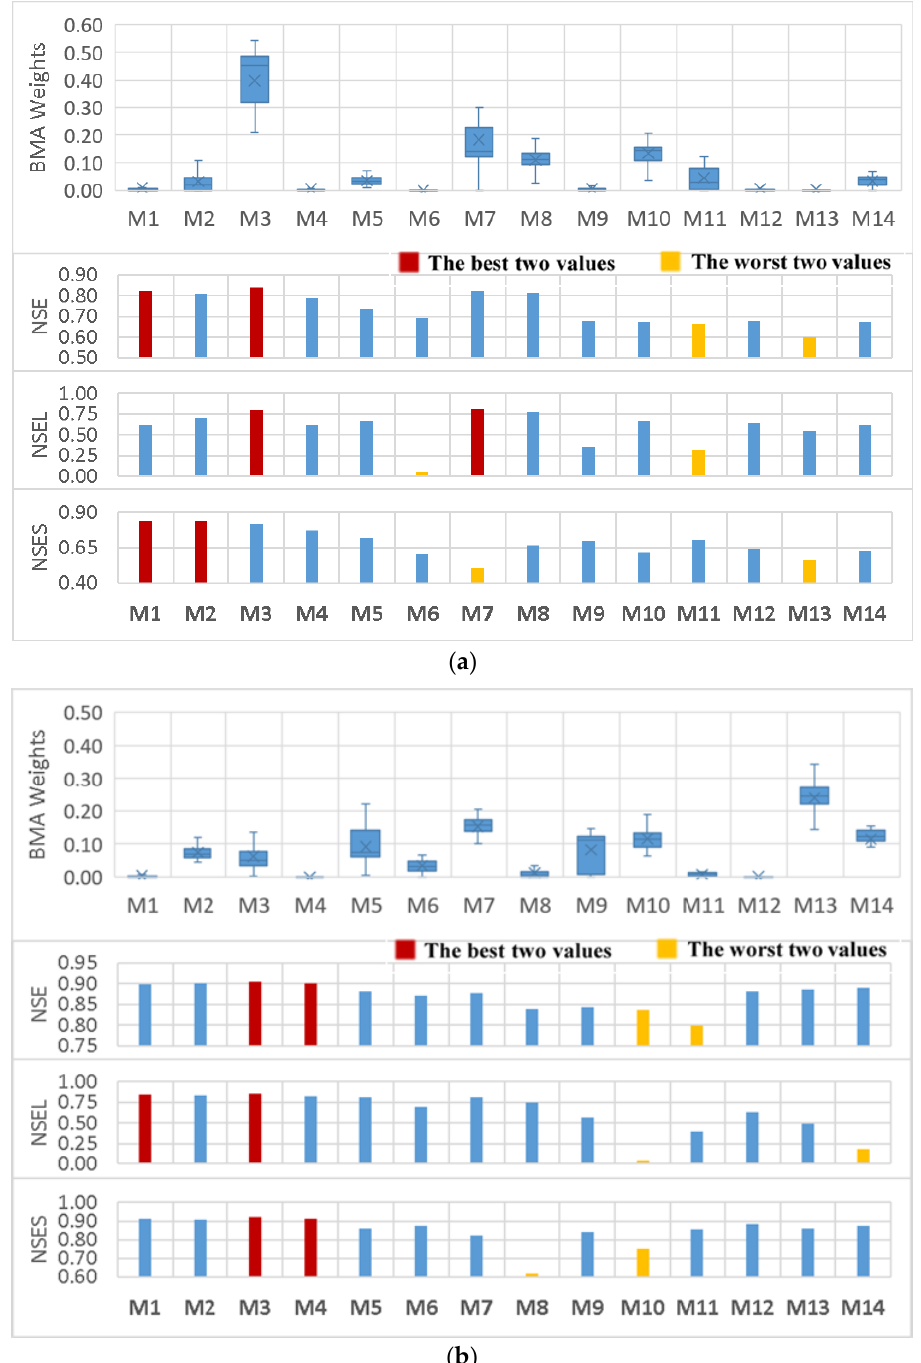
Figure 5. The boxplots of the calibrated BMA weights stem from different BMA modifications in comparison with the different performance criteria of each individual daily streamflow simulation for ( a ) the Big East River and ( b ) Black River watersheds during the calibration period.